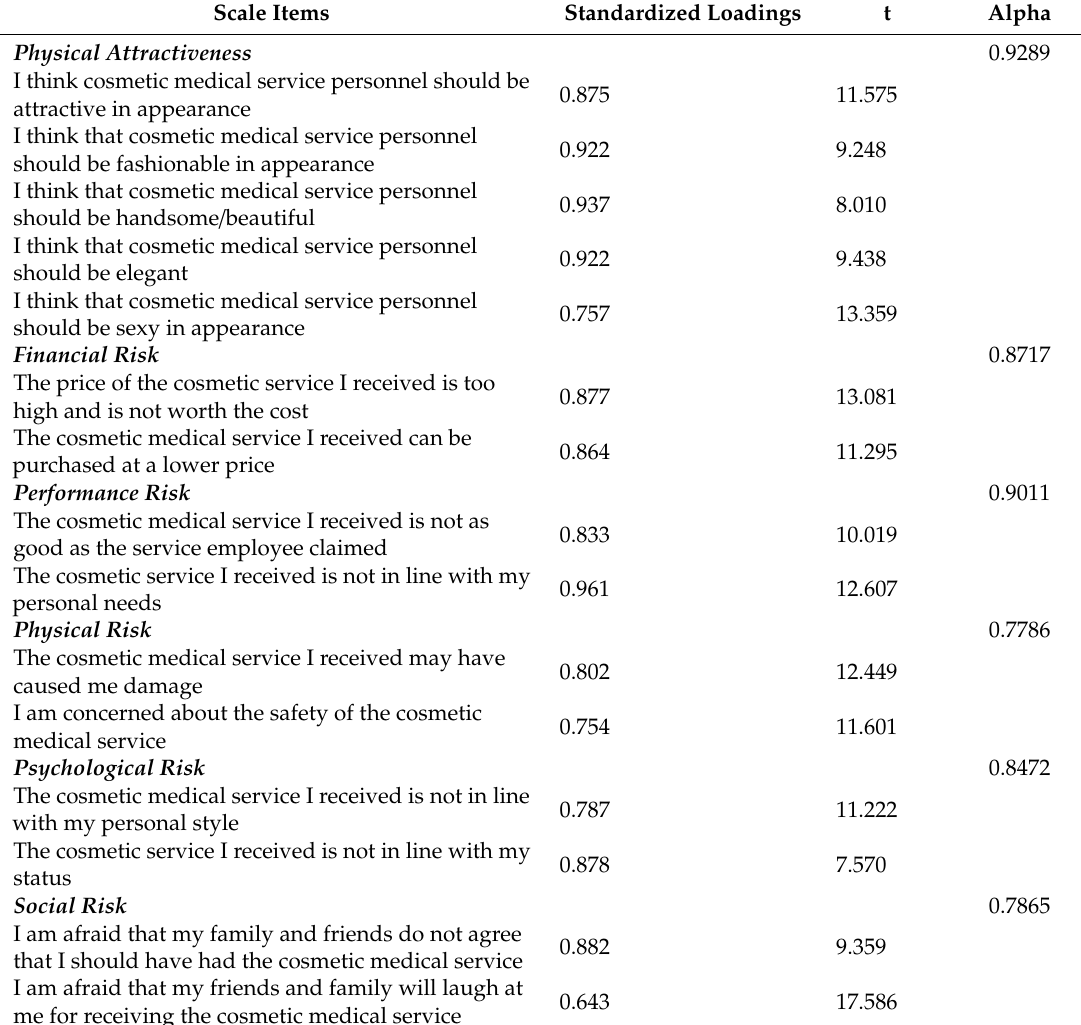
Table 2. Scale items, reliabilities, and confirmatory factor analysis